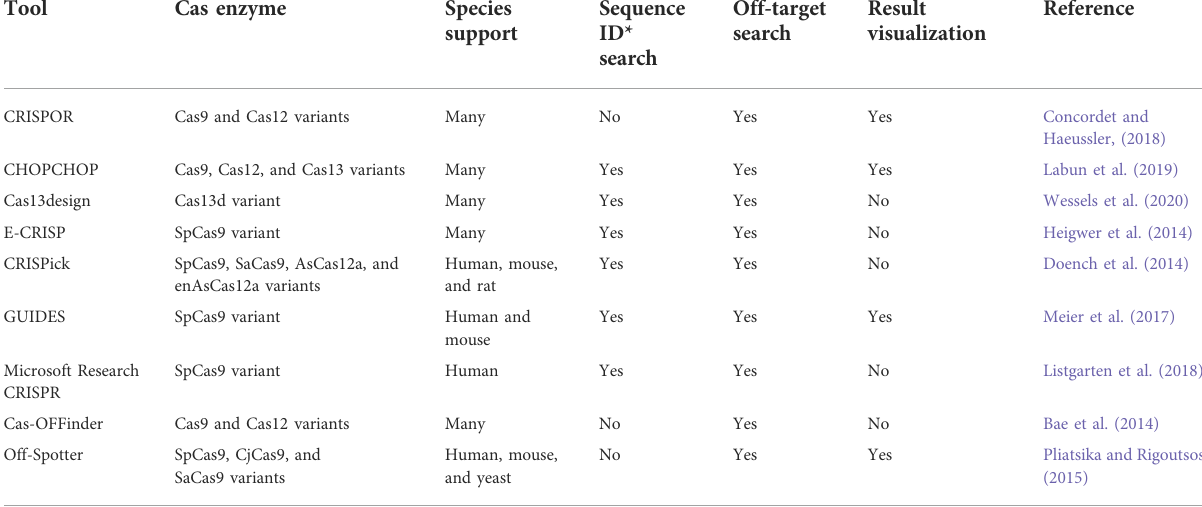
TABLE 1 Summary of commonly used crRNA design